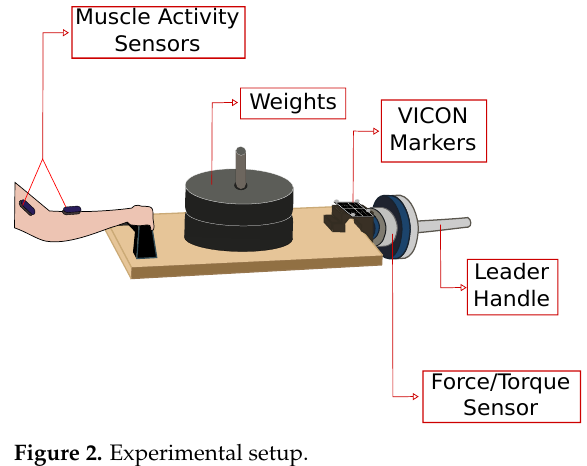
Figure 2. Experimental setup.